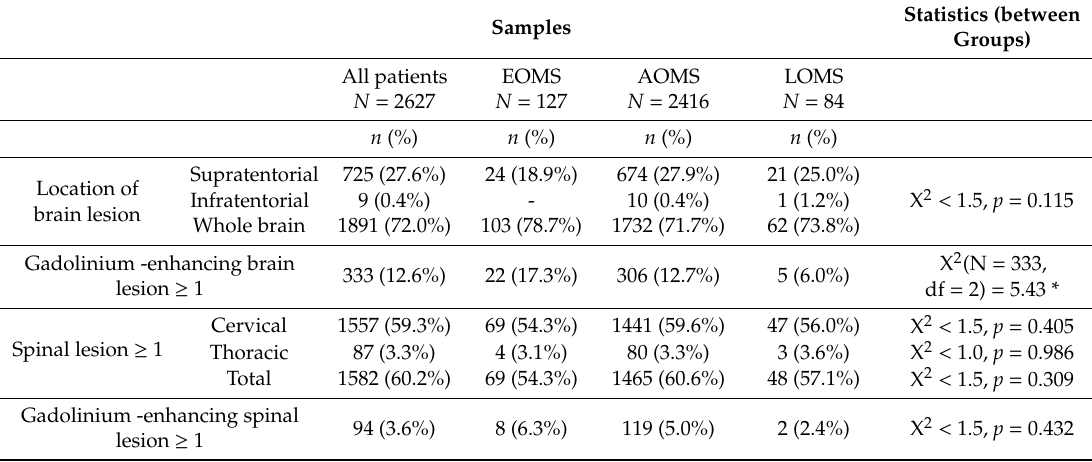
Table 3. Descriptive and inferential statistical indices of MRI features between participants with early onset (EOMS), adult onset (AOMS) and late onset multiple sclerosis